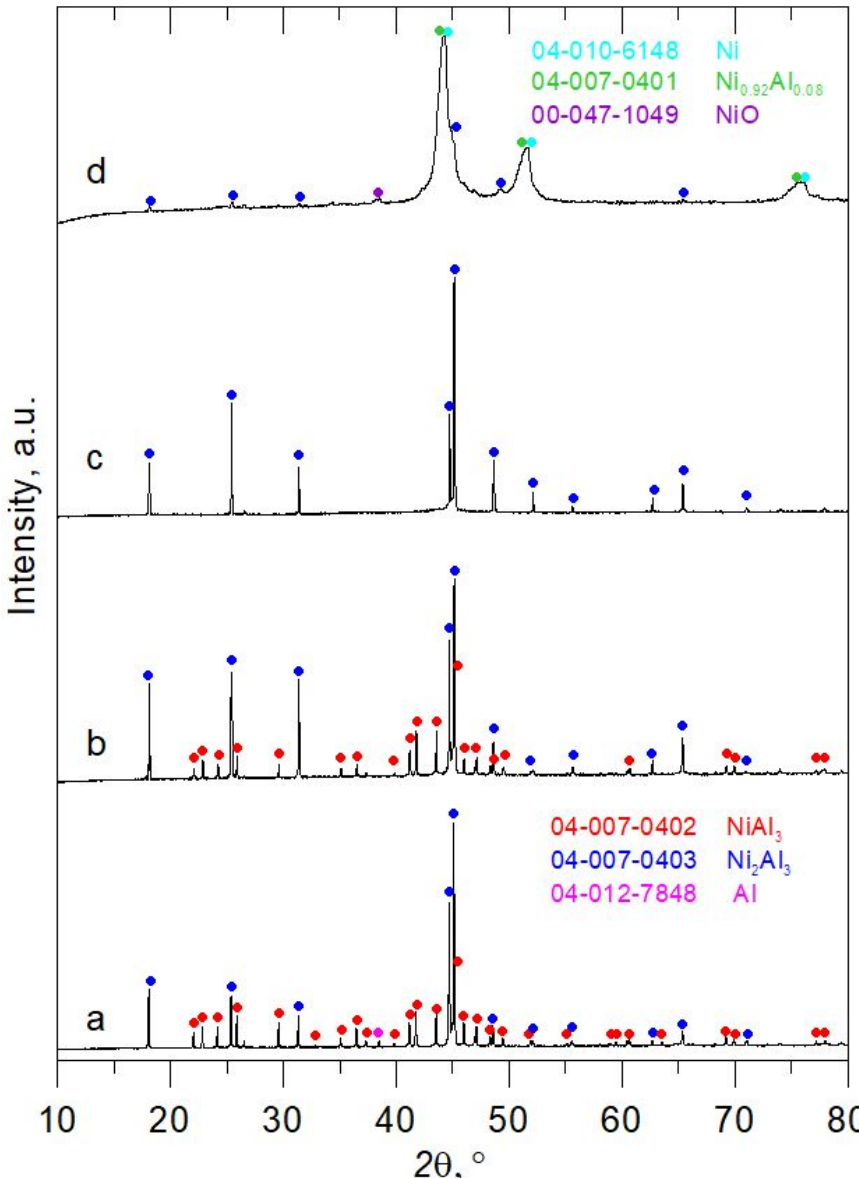
Figure 14 . Powder X-ray diffraction patterns of commercial Al-Ni alloy ( a ), of the used Al-Ni alloy Figure 14. Powder X-ray di ff raction patterns of commercial Al-Ni alloy ( a ), of the used Al-Ni alloy after 30 min in 1 wt.% NaOH/Ar-Cl ( b ), after 60 min ( c ) and at the end of HDC reaction ( d ). after 30 min in 1 wt.% NaOH / Ar-Cl ( b ), after 60 min ( c ) and at the end of HDC reaction ( d